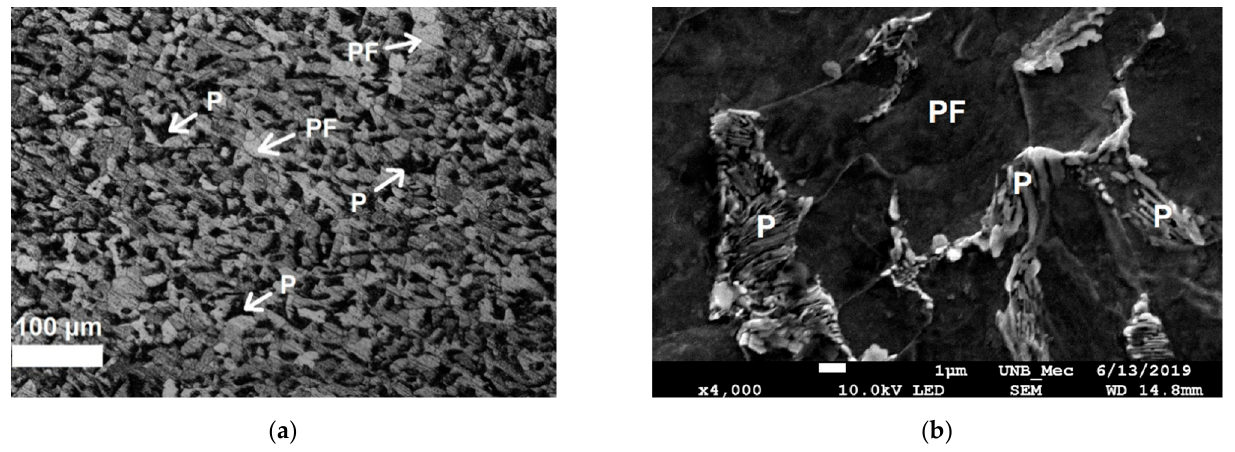
Figure 5. ( a ) Optical microscopy (magnification 200×) and ( b ) scanning electron microscopy (magnification 4000×) of base metal in sample 1. Etching: Nital 5%. P = Pearlite, PF = Primary Ferrite.